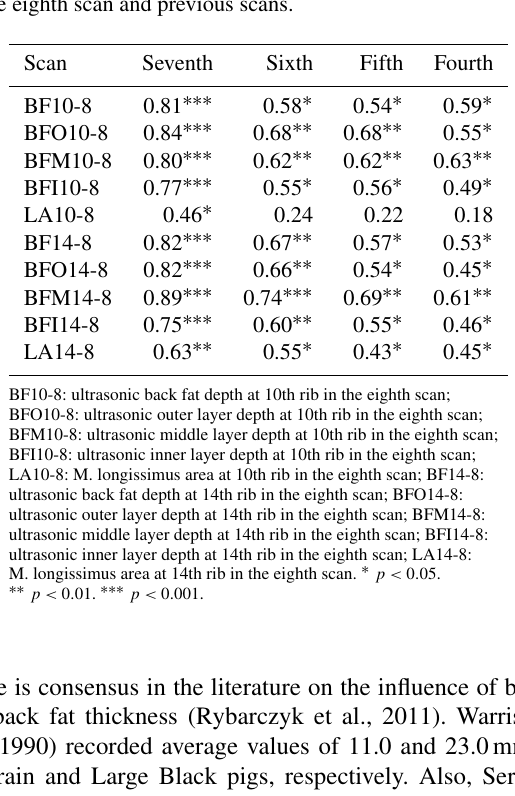
Table 5. Correlation coefficients between ultrasound measurements at the eighth scan and previous scans.